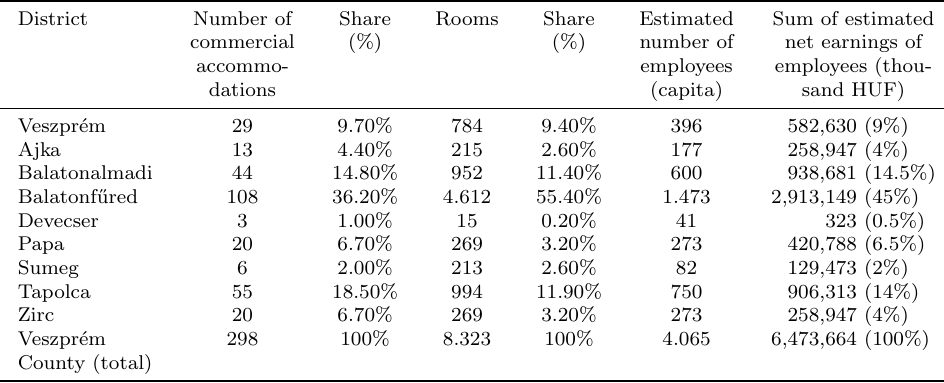
Figure 4: Percentage local embeddedness in spend and staffing¸5 establishments (2019) Table 1: Share of accommodations among the 9 districts of Veszpr´em County